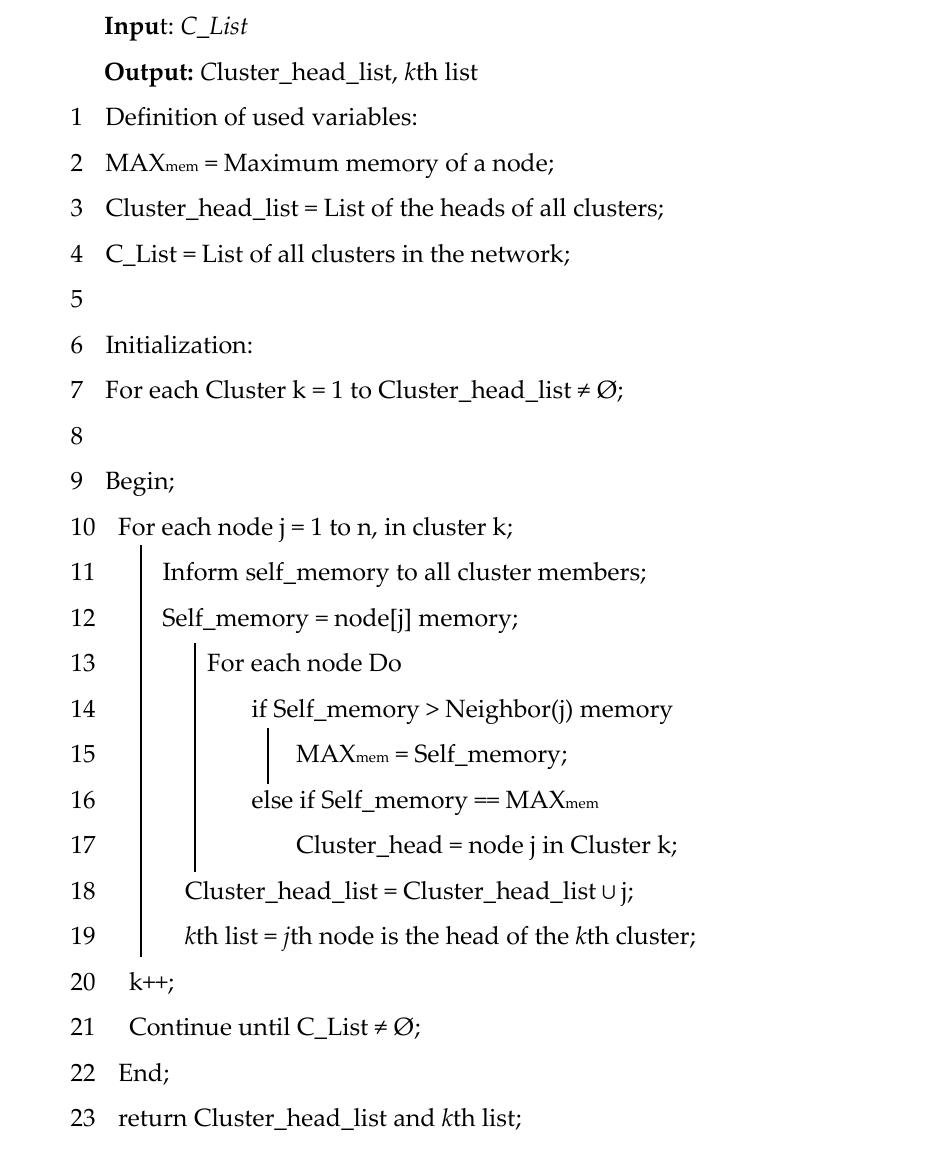
Algorithm 3: An algorithm to make a cluster